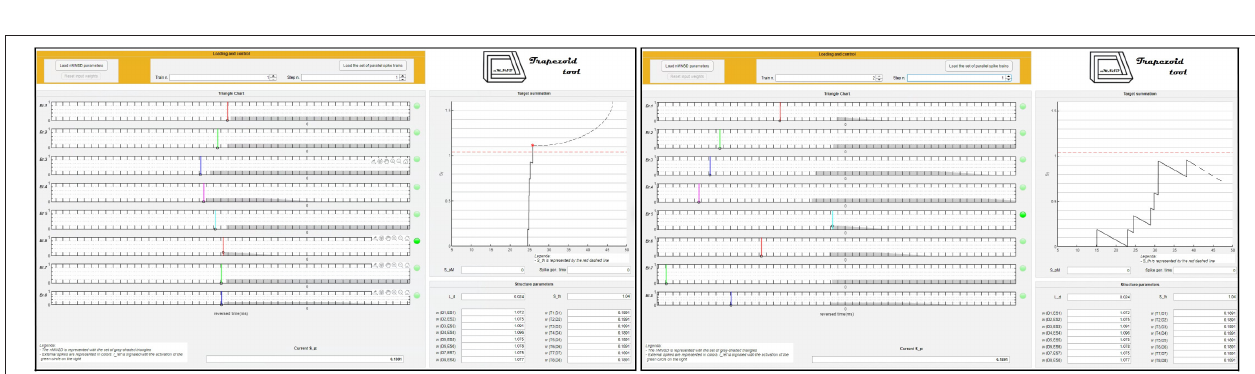
of intensity of the field and coded this number to the input neurons using Equation (18). Heterosynaptic lateral connections are activated between adjacent neurons during learning and disabled during